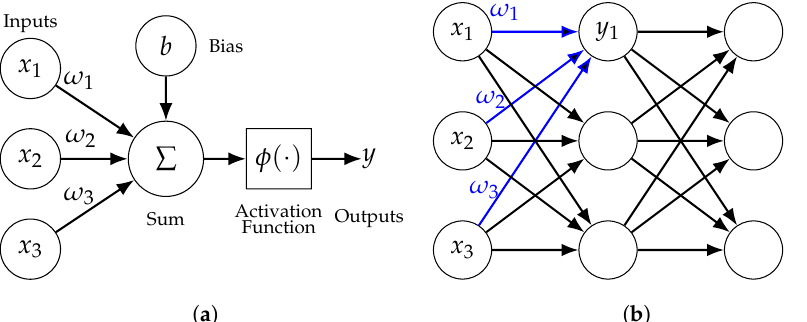
Figure 2. (a) The neuron output y is the weighted sum of the elements in input vector x and bias b followed by a non-linear activation function ϕ ( · ) . Activation functions are normally Sigmod , Tanh , or ReLU [38]. (b) A toy neural network with three layers, in which neuron outputs pass in forward direction indicated by the green arrows. ω n are the weights.